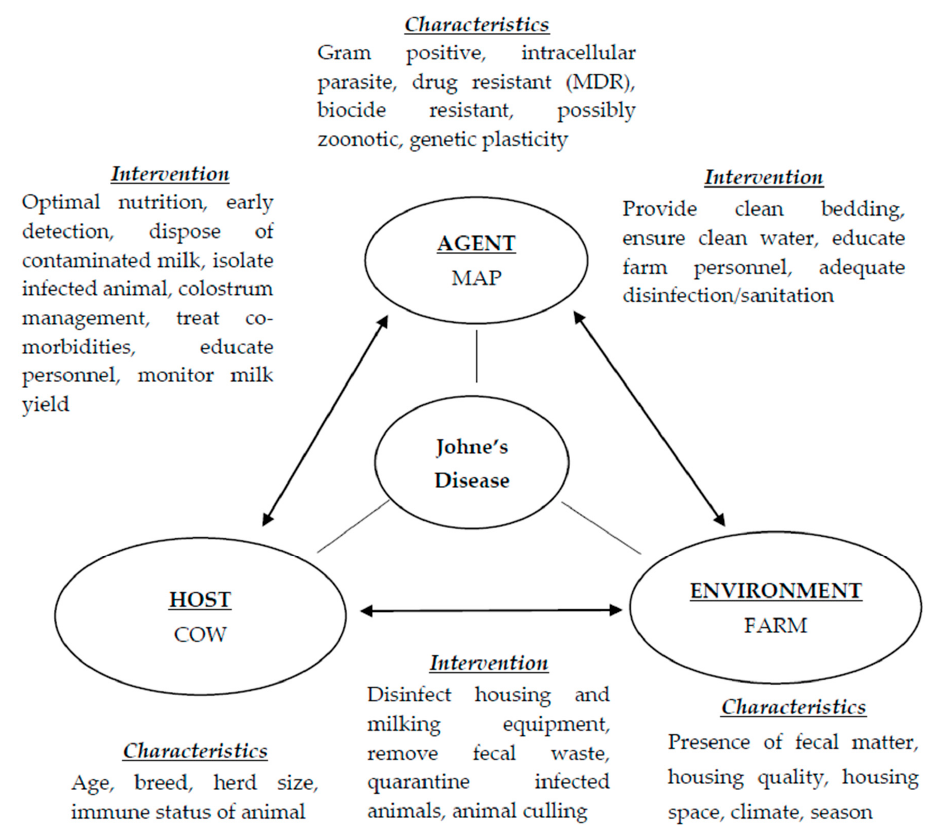
Figure 1. The triad of Johne’s disease outlining associated characteristics and intervention methods for disease prevention on dairy